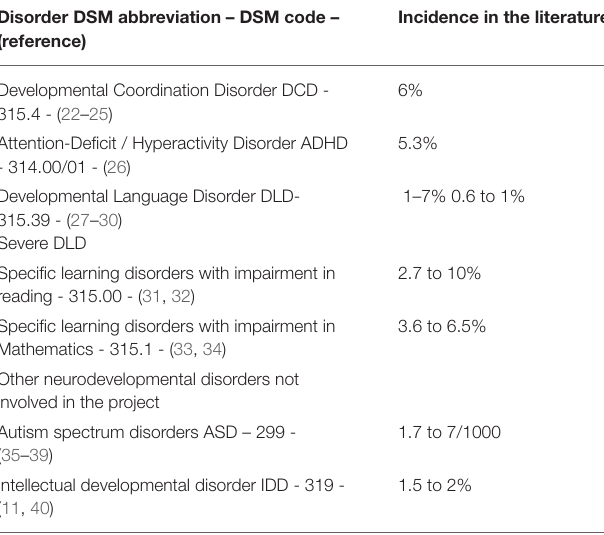
TABLE 1 | Incidence and DSM codes for the main NDD involved in the project, as well as for differential diagnosis. Disorder DSM abbreviation – DSM code –